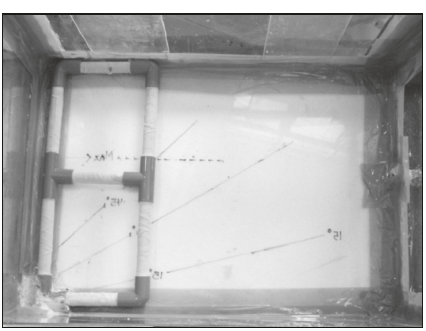
Figure 4: Layout of piping to introduce